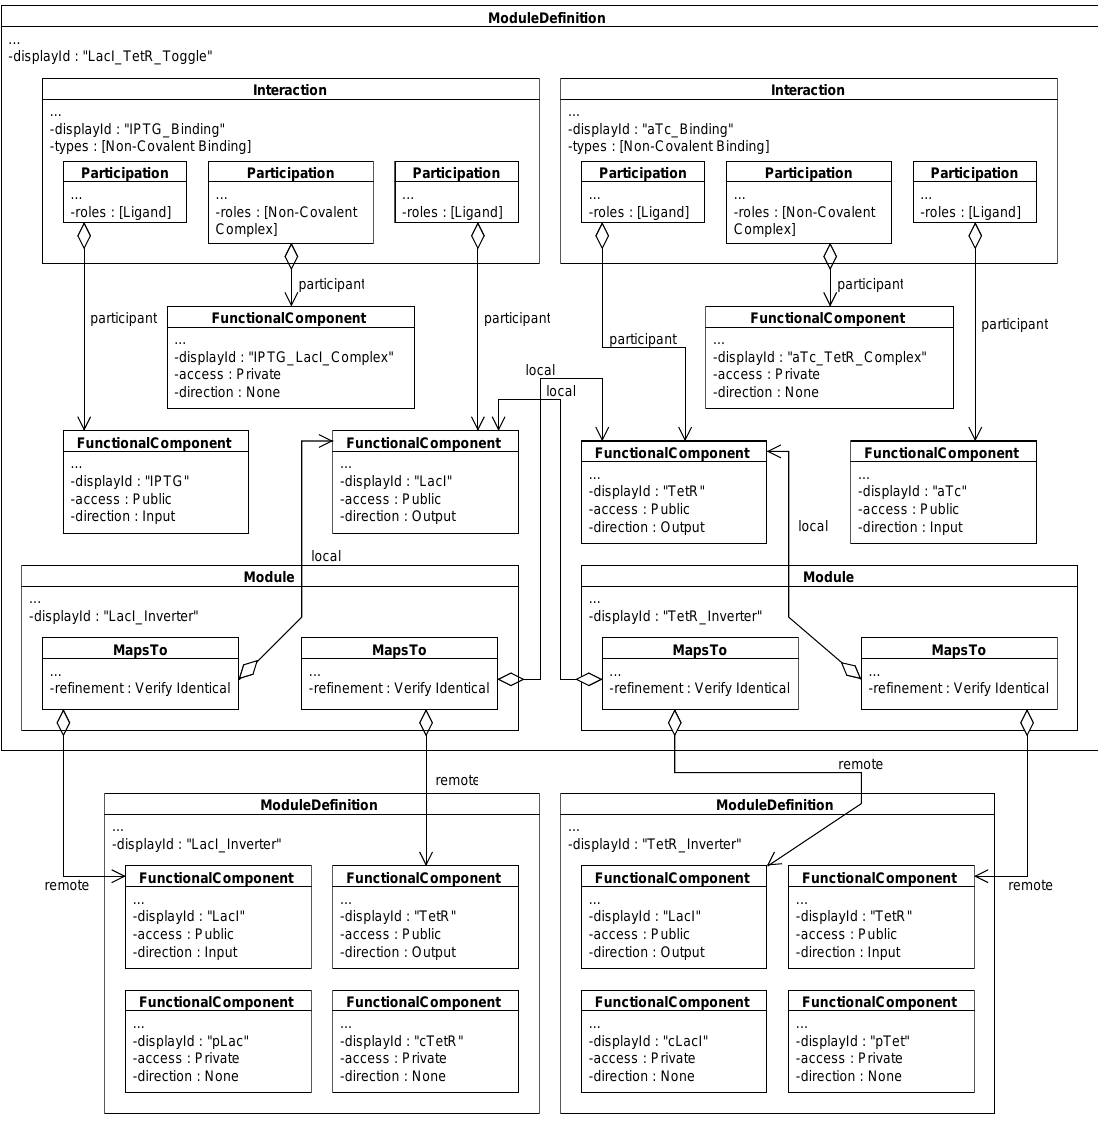
Figure 28: Composite ModuleDefinition of the LacI/TetR toggle switch. This ModuleDefinition contains the Module objects that instantiate LacI and TetR inverter ModuleDefinition objects. It also contains FunctionalComponent objects that instantiate the ComponentDefinition objects for the LacI/TetR transcription factors and IPTG/aTc small molecules. These FunctionalComponent objects each participate in a non-covalent binding Interaction . To com- plete the composition of the toggle switch, MapsTo objects are used to indicate that the output of the LacI inverter ModuleDefinition is identical to the input of the TetR inverter ModuleDefinition and vice versa.